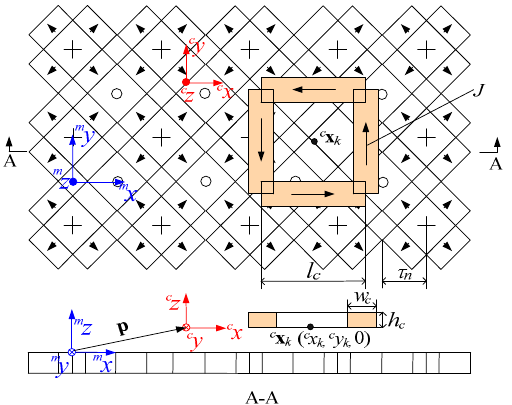
Figure 2. Top views and A-A view of the components of a maglev planar motor: a Halbach array and a coil.